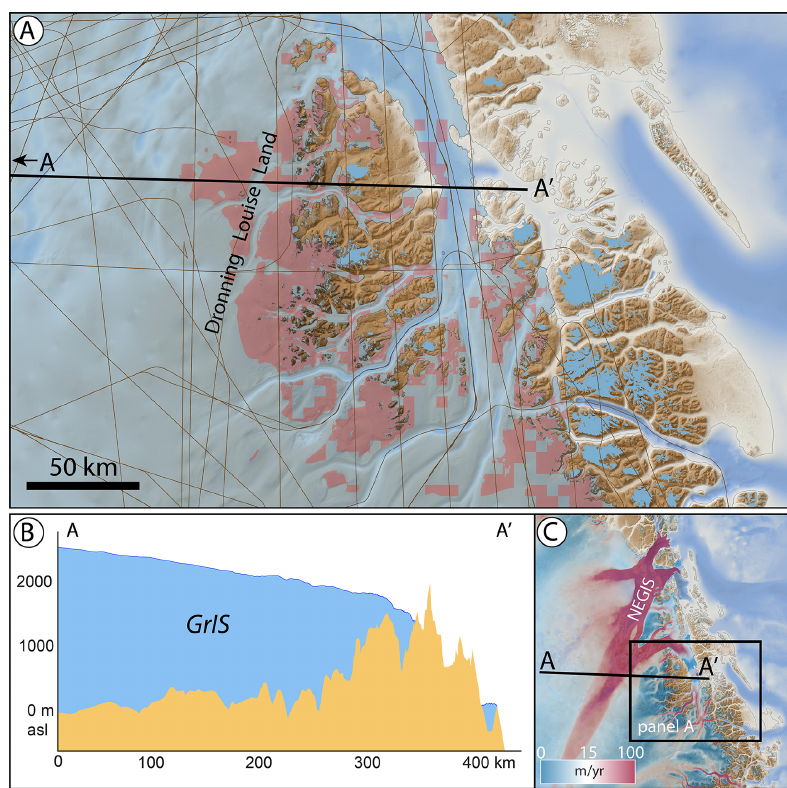
Figure 8. (a) Dronning Louise Land showing areas that meet drill requirements; NASA Operation IceBridge (OIB) flight lines are shown as thin brown lines. (b) Topographic profile of bed and GrIS surface from Bed Machine v3 (Morlighem et al., 2017); cross-section line shown in panel (c) . (c) NE Greenland with surface velocity showing Northeast Greenland Ice Stream (NEGIS) and location of panel (a) ; velocity from Greenland Ice Sheet velocity map from Sentinel-1, winter campaign 2019/2020 (version 1.3); QGreenland v2.0. Basemap topography and bathymetry from Morlighem et al.